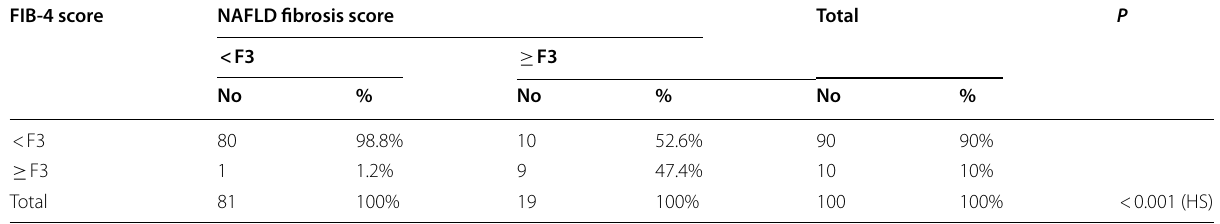
Table 11 Degree of agreement between FIB-4 score results and NAFLD fibrosis score results FIB-4 score